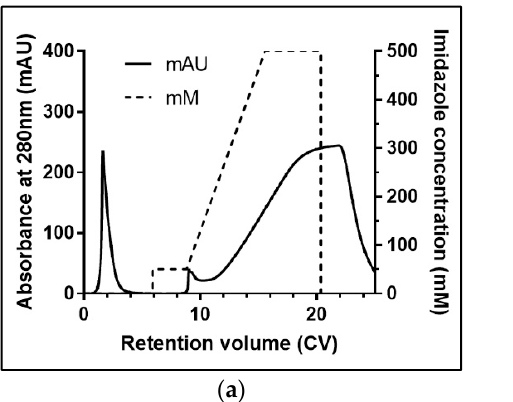
Figure 7. Affinity chromatography binding assay. SsZntA is treated with TEVp to remove the HisTag, in this way it cannot bind to a Ni 2+ beads, while the HisTagged nanobody can. The binding was assessed by incubating HisTag-free SsZntA with HisTagged Nb and loading them to an Ni-NTA column. When SsZntA forms a complex with the Nb, it indirectly binds to the Ni 2+ beads (via the Nb’s HisTag) and can be eluted from the Ni 2+ -immobilized resin. N.B. All the representations are out of scale for clarity.